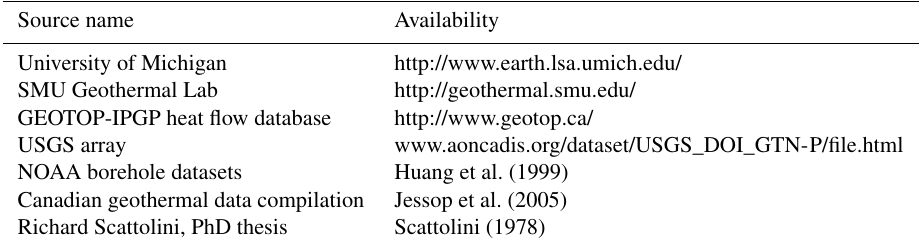
Table 1. Sources of the temperature–depth profiles.